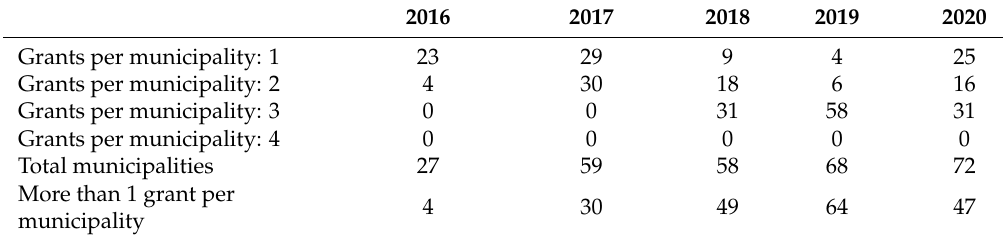
Table 6. Municipalities without an FS, according to the number of sołectwa participating in the programme.